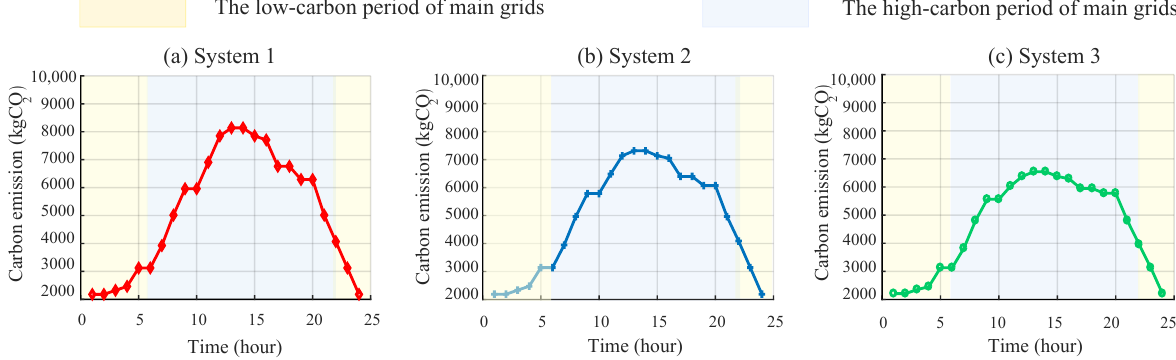
Figure 8. Comparison of carbon emissions of the three systems.